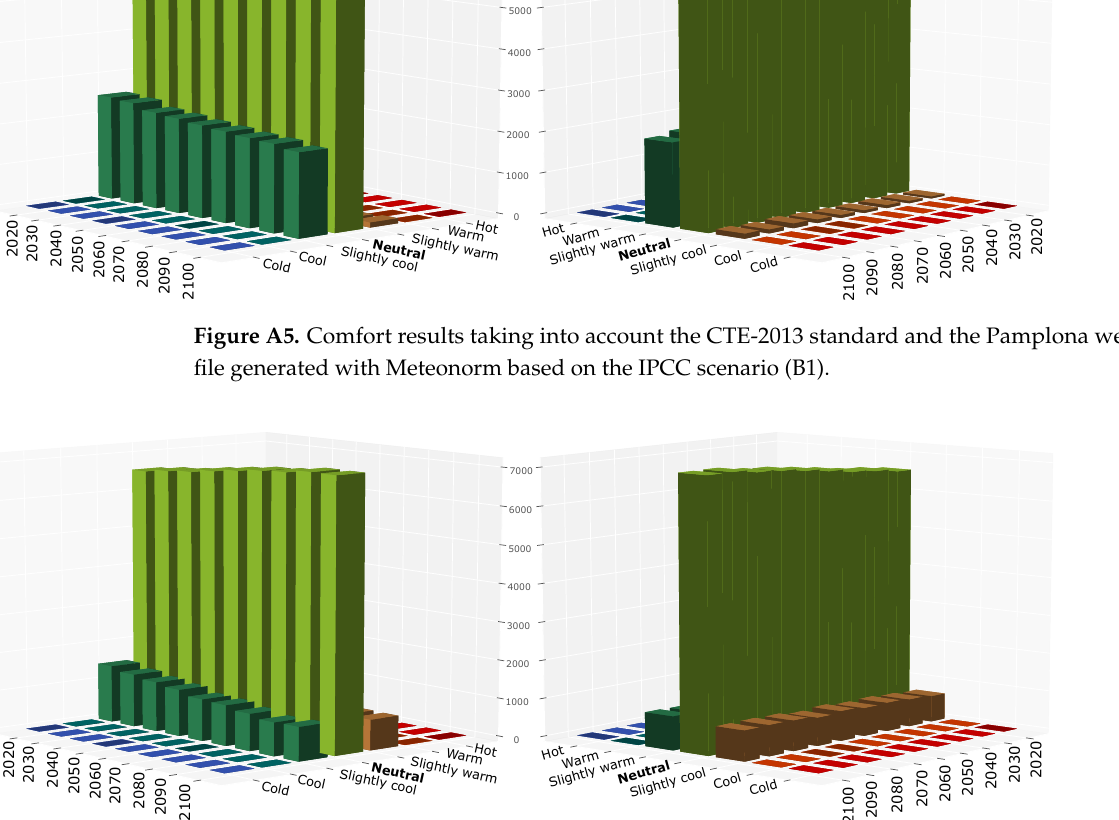
Figure A6. Comfort results taking into account the CTE-2019 standard and the Pamplona weather file generated with Meteonorm based on the IPCC scenario